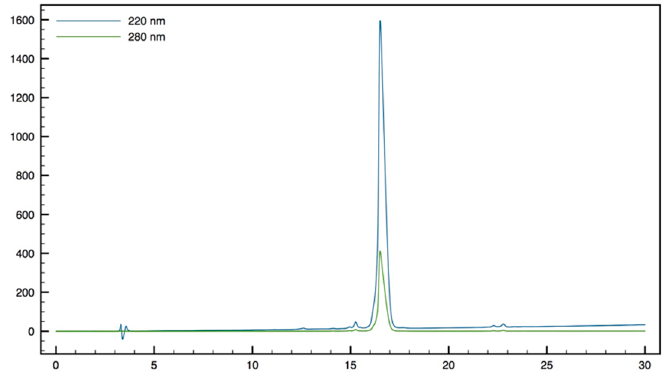
Figure 17. HPLC profile of Gdm- β 2,2 - h -bis-Arg-Tbt-OMe 14 Figure 17 . HPLC profile of Gdm- β 2,2 -h-bis-Arg-Tbt-OMe 14 .